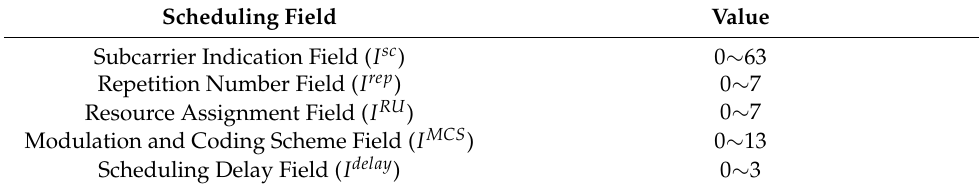
Table 3. The Main Scheduling Fields. Scheduling Field Value Subcarrier Indication Field ( I sc ) 0 ∼